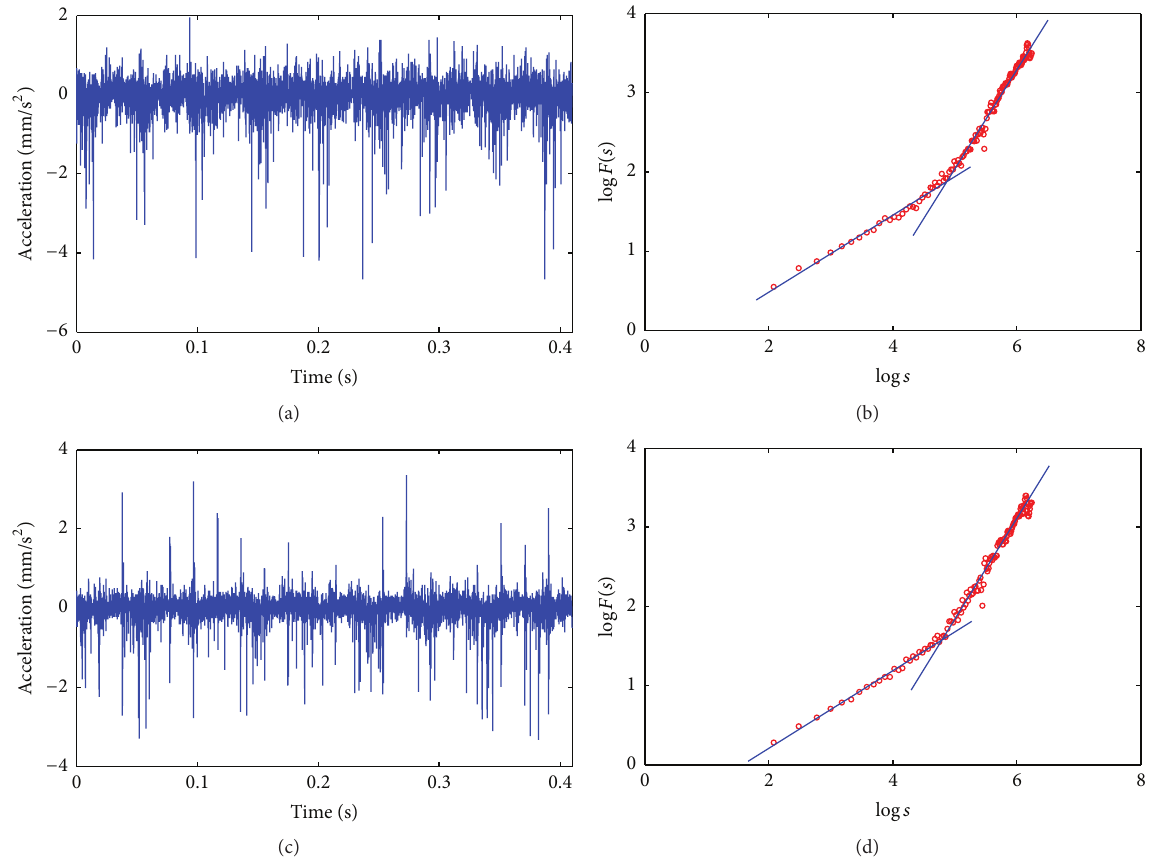
Figure 5: The representative vibration signal, power spectrum, and the DFA curves obtained from the two types of gears with a rotation speed of 985 rpm: (a) Signal from a “Normal” gear. (b) DFA from a “Normal” gear. (c) Signal from a “Toothless” gear. (d) DFA from a “Toothless” gear.